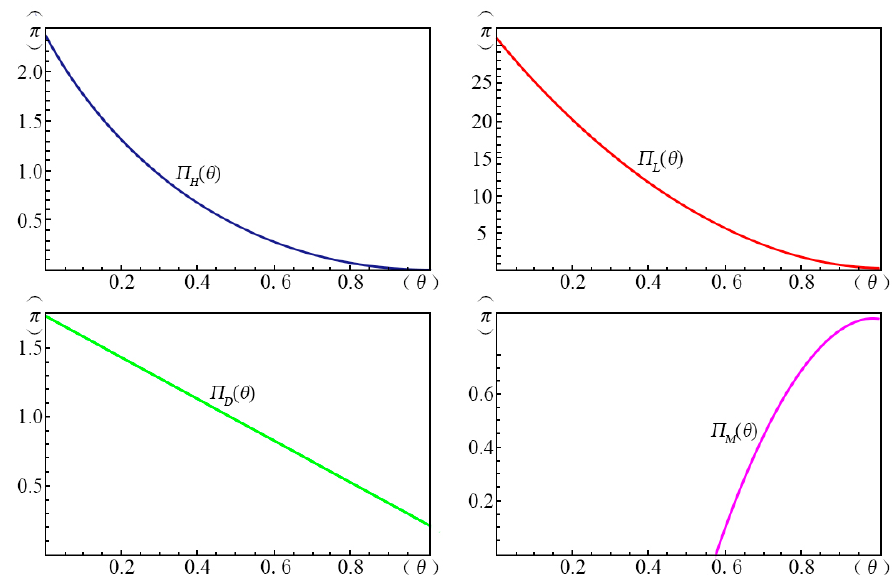
Figure 9. The influence of θ on the profits of the four pricing strategies.